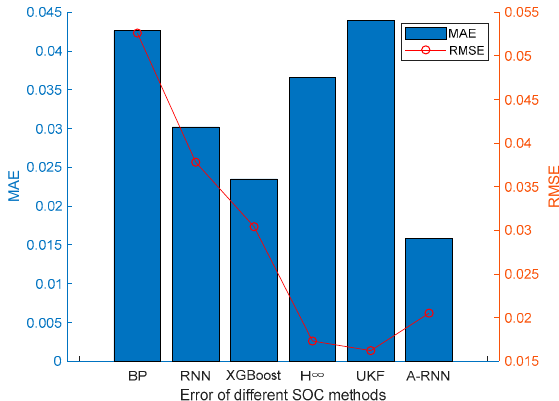
Figure 13. RMSE and MAE of different methods.